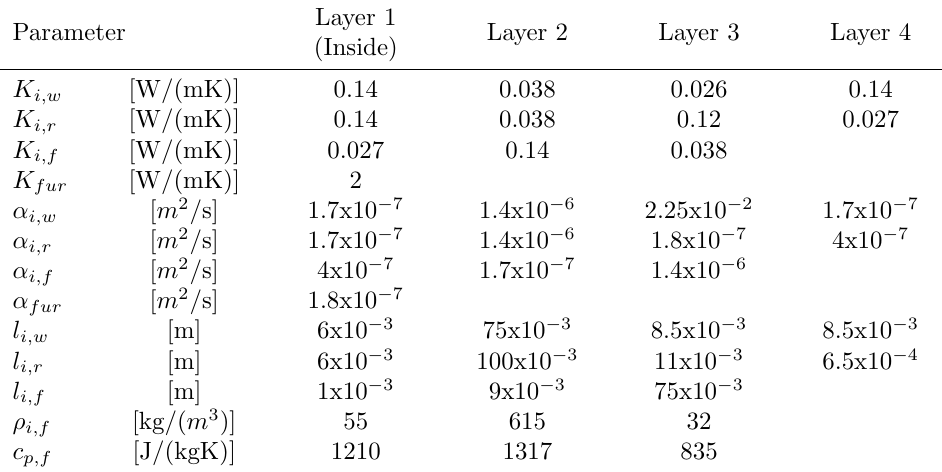
Table 1: Parameters applicable to walls, floor, roof and furniture